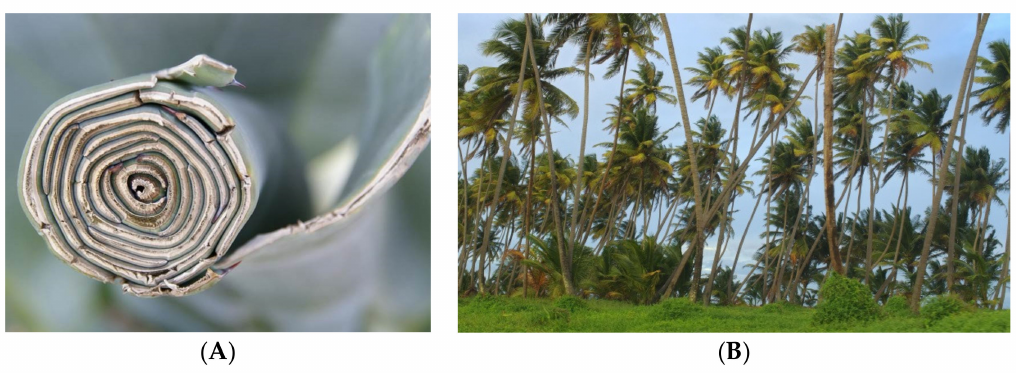
Figure 4. The example of the source for plant fibres: ( A ) Agave Americana L. and its structure, ( B ) palm forest in Trinidad